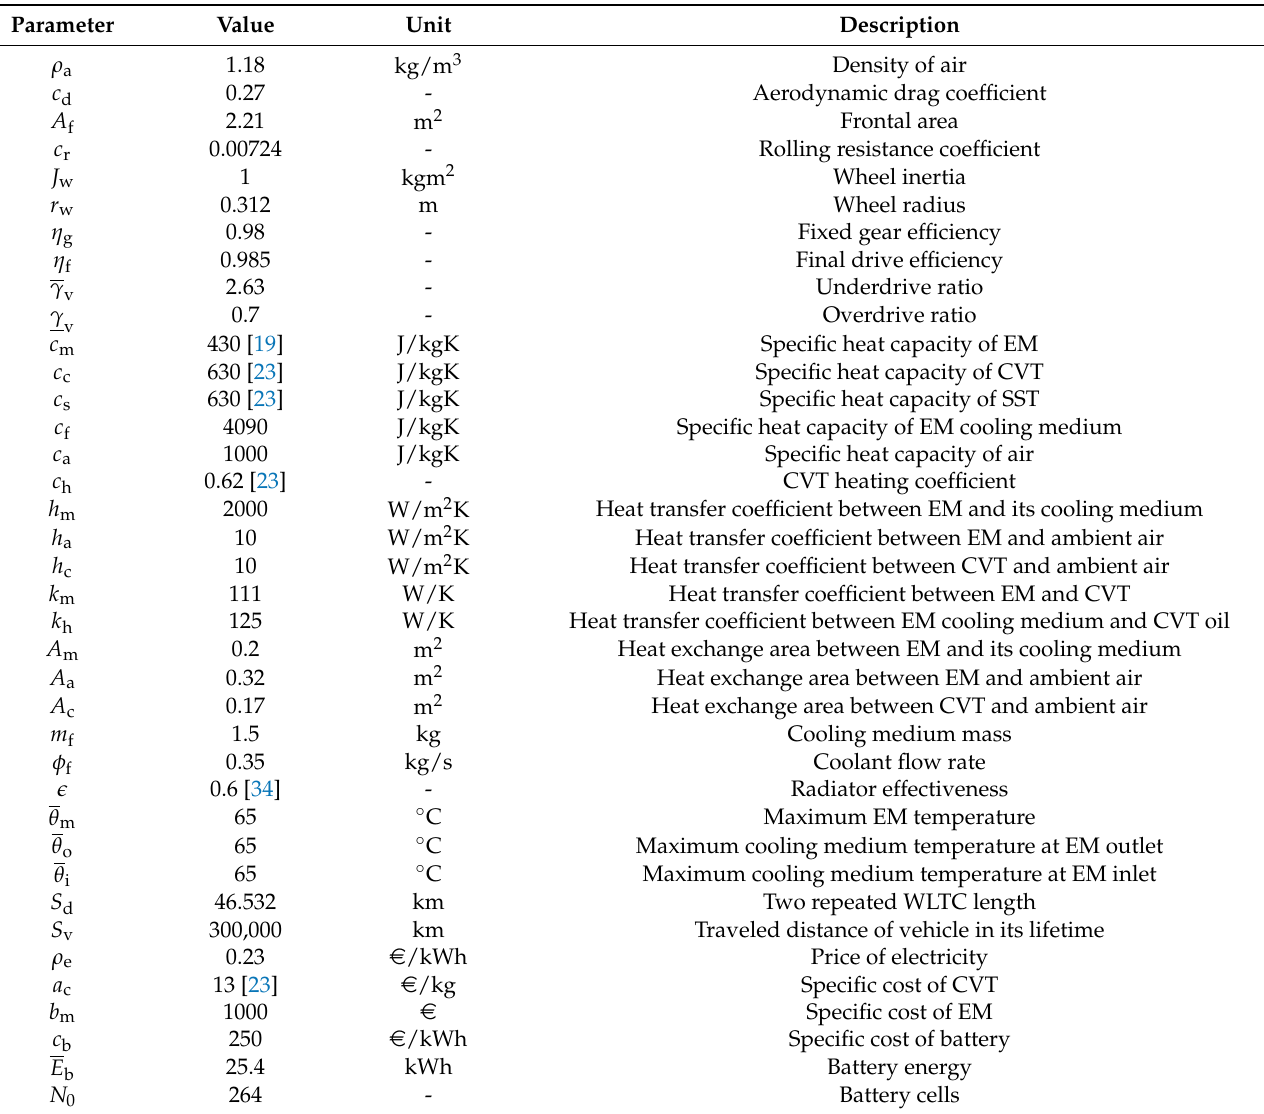
Table A1. Main parameters of EV